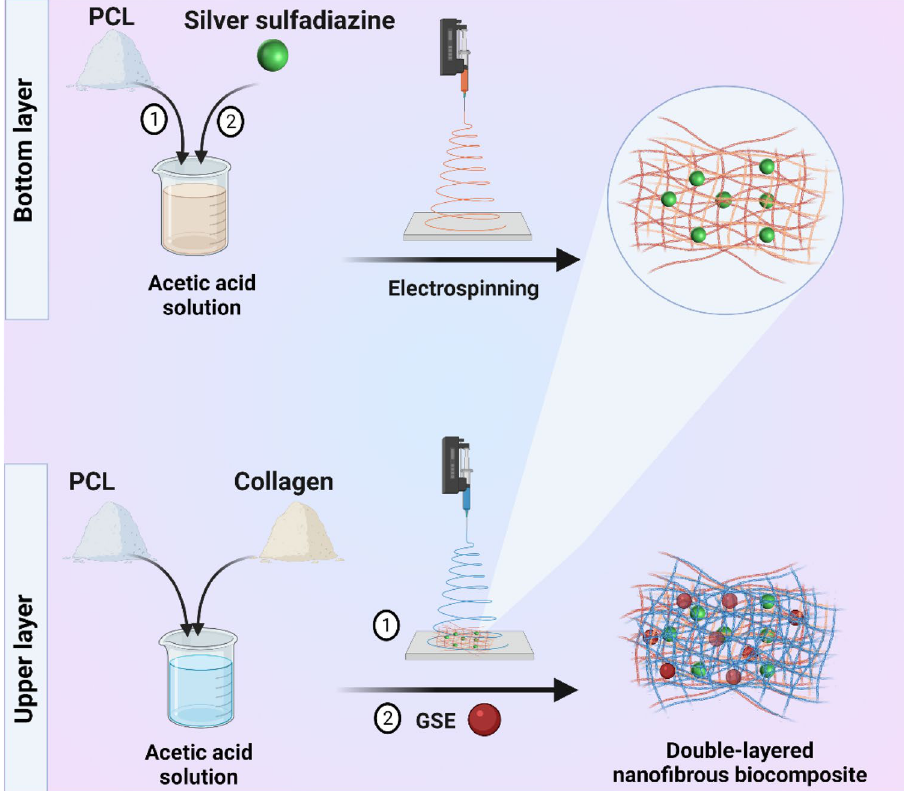
Figure 1. Manufacturing process of the scaffold via electrospining. Schematic illustration of fabrication of the double-layered nanofibrous